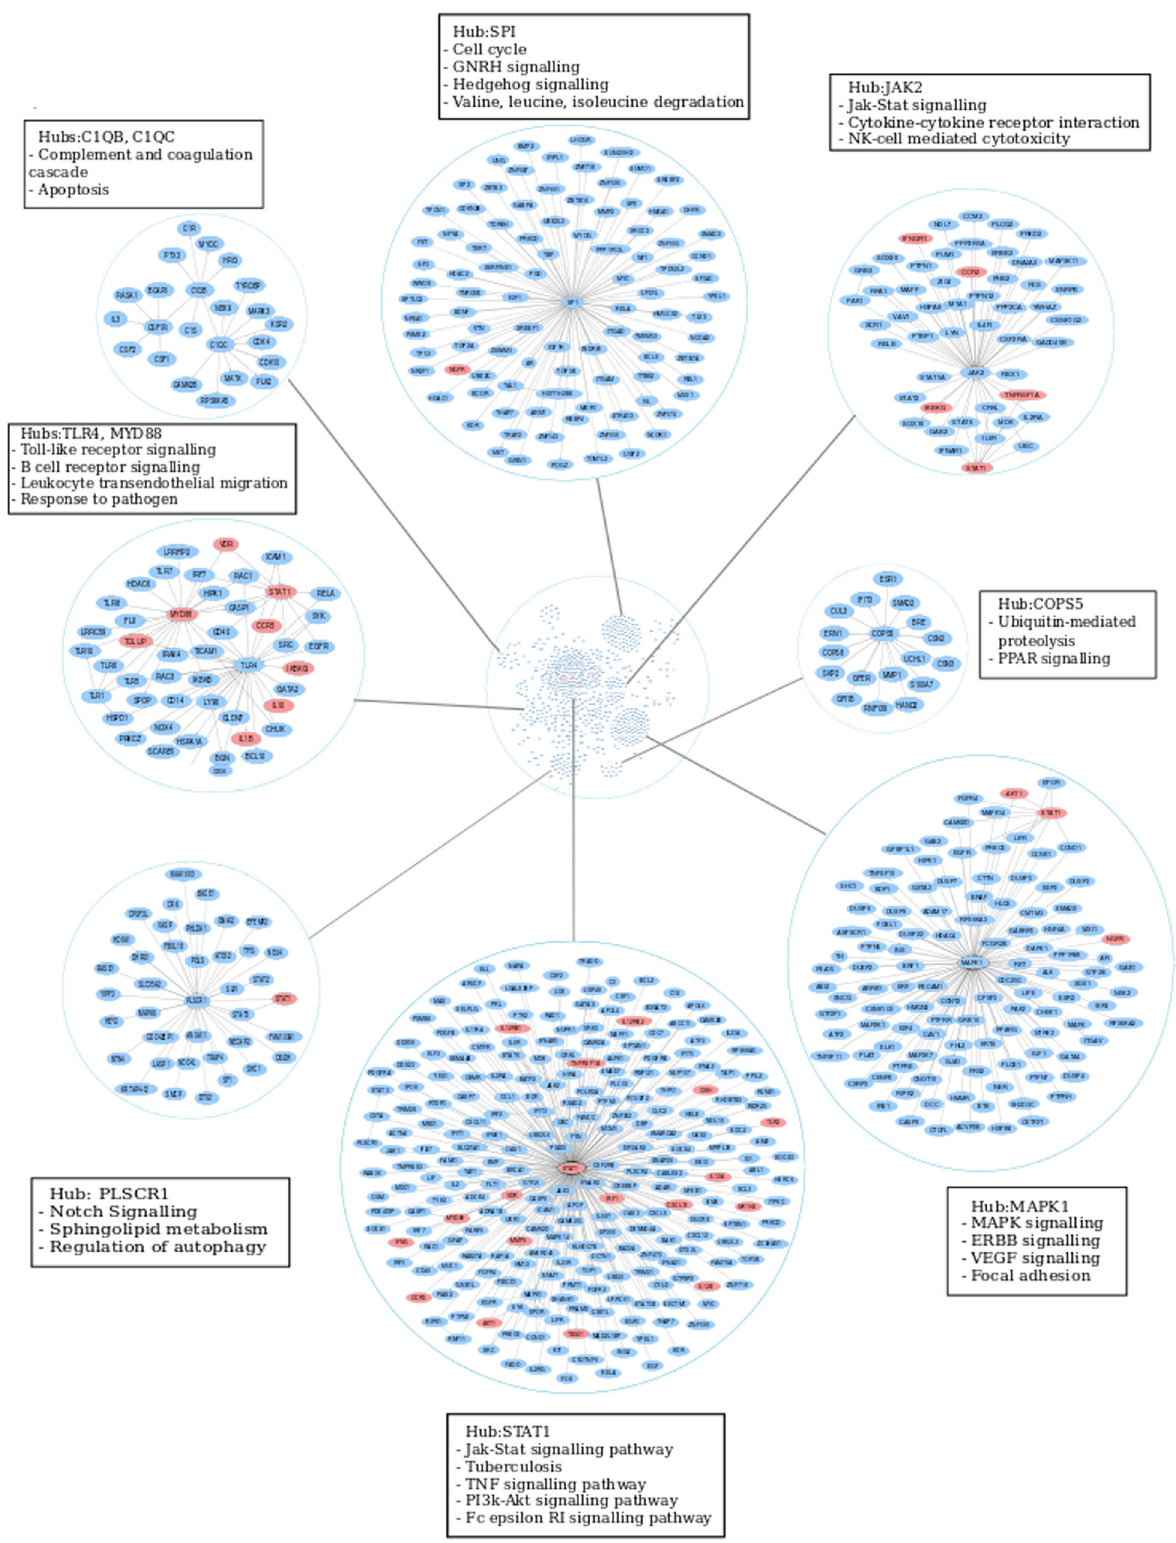
Fig. 4 The Tier-2 common core depicting highly active nodes and their corresponding pathways enriched in disease. The STAT-1 centric responses are retained at Tier 2 and the emergence of other well connected hubs such as MAPK1 and SP1 is also observed, encompassing myriad signalling processes and their crosstalk across multiple cell and tissue types, captured in the whole blood milieu. Genes reported to have SNPs in different studies ascribing susceptibility to tuberculosis are marked in red in this